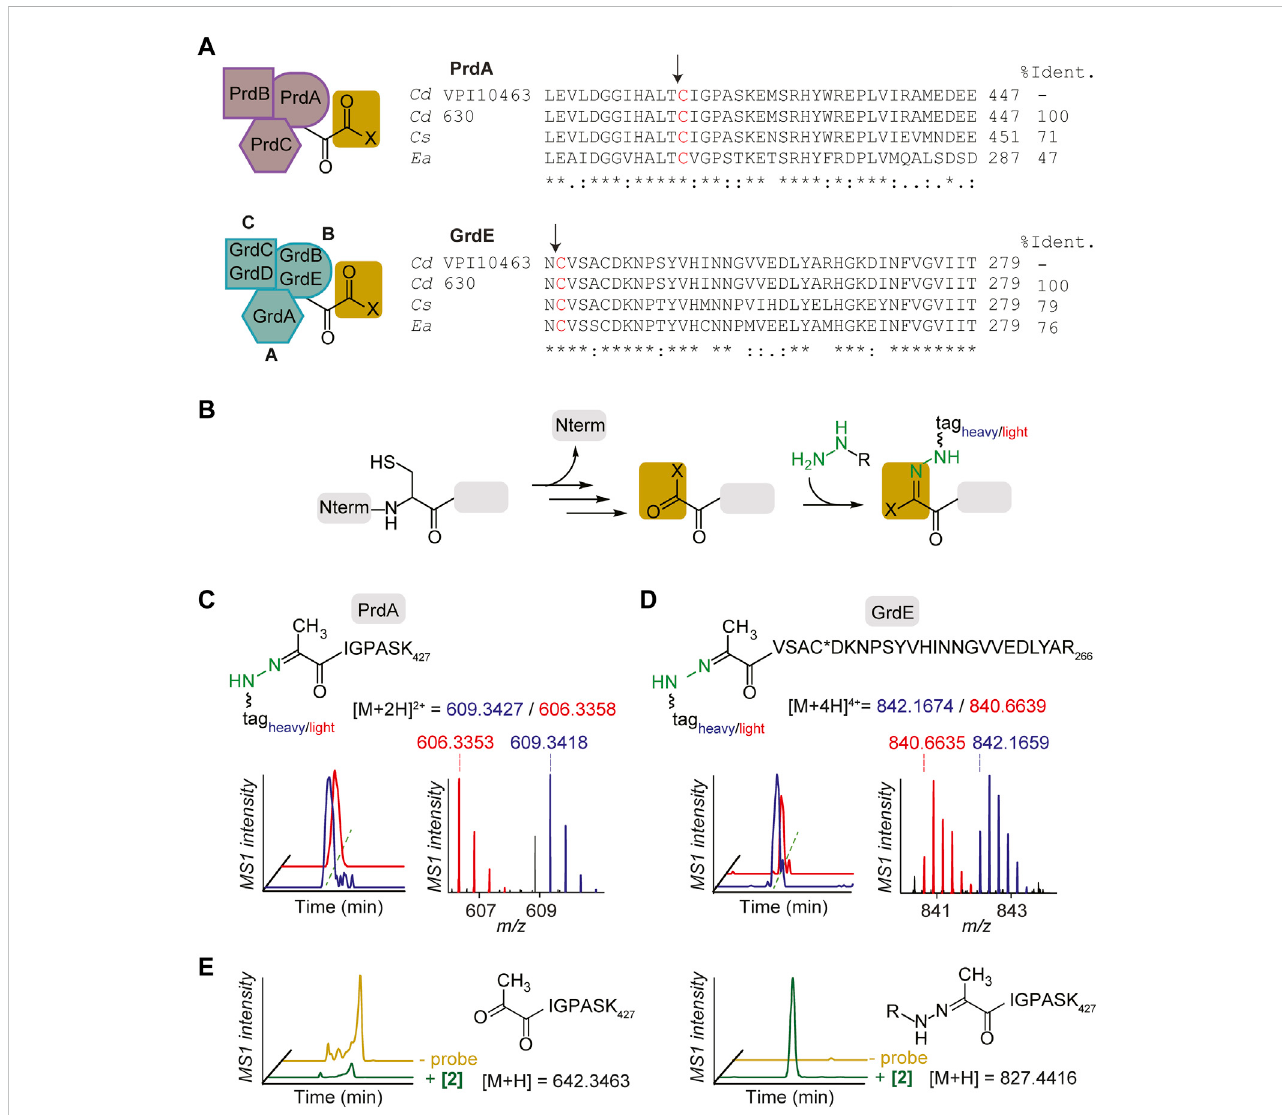
FIGURE 3 Characterizationofhydrazine-reactivesitesinPRandGRofSticklandfermentation. (A) ,PRcomplexandGRcomplexproteinsubunits( left ).Alignmentof bacterial reductase subunits, PrdA and GrdE, with putative sites of proteolysis and formation of carbonyl groups ( right ). The arrows note sites of proteolysis. Sites of modi fi cation are shown in red. Cd , Clostridioides dif fi cile ; Cs , Clostridium sticklandii ; Ea , Eubacterium acidaminophilum . (B) , Labelling mechanism of carbonylcofactorsbyhydrazinethroughSchiffbaseformation. (C) ,Theidentityoftheprobe 2 -labelledpeptide(aa421 – 427)inPrdAinculture.Extracted MS1 ion chromatograms and corresponding isotopic envelope of co-eluting heavy- and light-tagged peptides are shown in blue and red, respectively. (D) , The identity of the probe 2 -labelled peptide (aa 242 – 266) in GrdE in culture. C* is site of static modi fi cation by carbamidomethyl. Extracted MS1 ion chromatograms and corresponding isotopic envelope of co-eluting heavy- and light-tagged peptides are shown in blue and red, respectively. See SupplementaryFiguresS10 – S17;SupplementaryTableS4forfurthercharacterization. (E) ,Extractedparentionchromatogramsofthe N -terminalPvylpeptide of PrdA ( left ) and 2 -Pvyl peptide adduct ( right ) in the absence and presence of 2 in vitro . See Supplementary Figure S18 for further